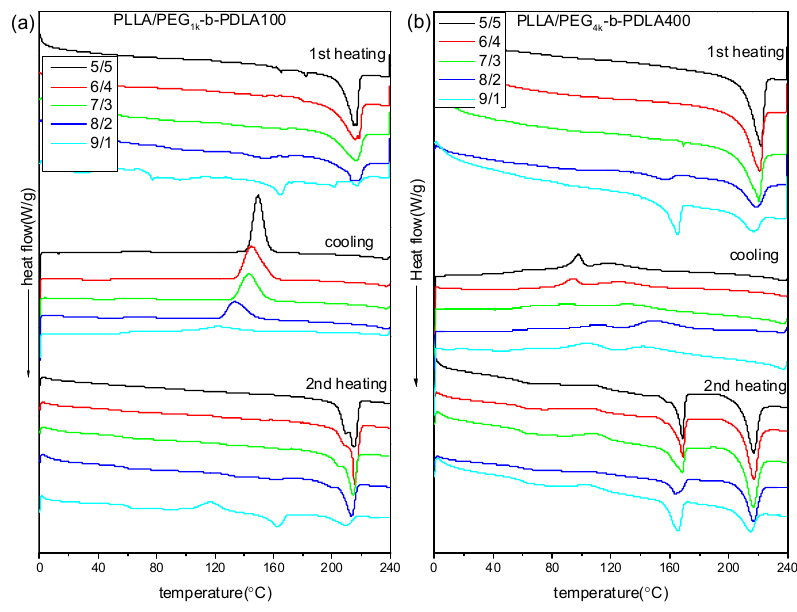
Figure 2. Differential scanning calorimetry (DSC) curves of PLLA/PDLA-PEG 1k -PDLA100 ( a ) and PLLA/PDLA-PEG 4k -PDLA400 ( b ) with different L/D ratios.